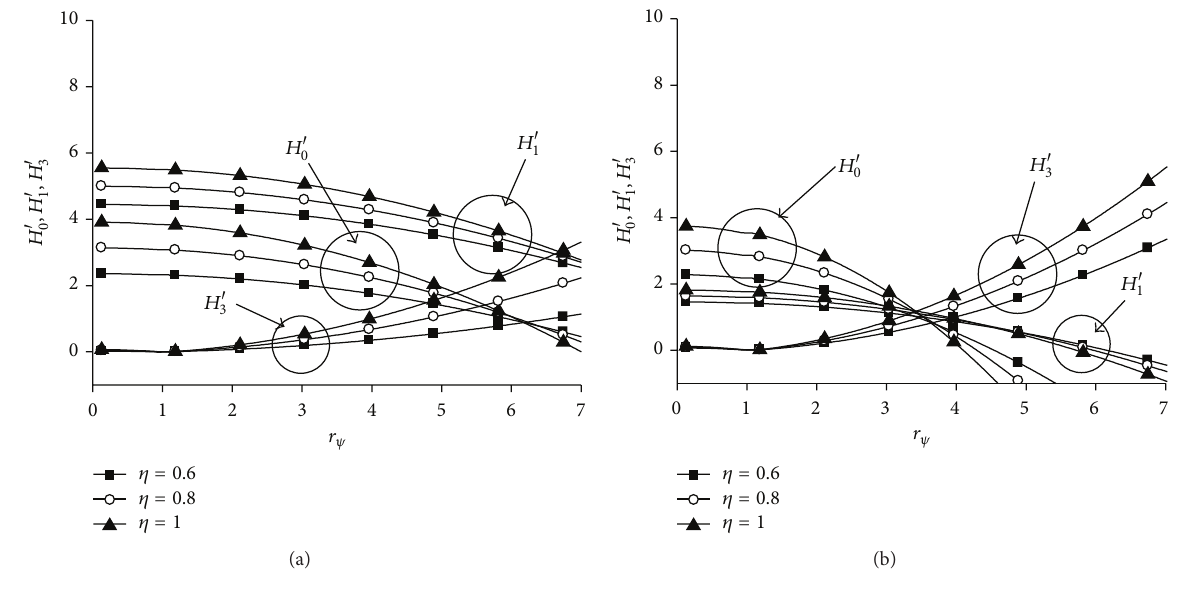
Figure 7: Coefficients of stability: (a) 𝑟 𝑚 = 0.03 ; (b) 𝑟 𝑚 = 0.09 .